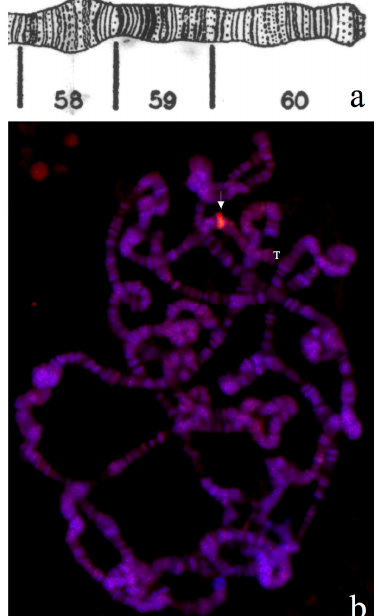
Figure 11. Drawing of chromosome sections 58-60 in arm 2R modified from [24]. ( a ). Magnification of one polytene complement from the top of Figure 10 displaying merged signals of antibody, TO and DAPI staining (arrow) ( b ) showing in detail that polytene chromosome section 59E carrying the bw D allele is reactive to TO. Arm 2R telomere at chromosome section 60 is indicated (T).